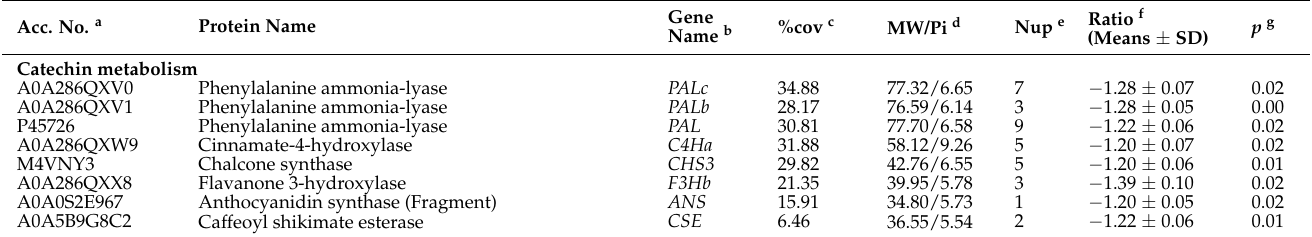
Figure 3. Concentration of catechins, gallic acid, caffeine and amino acids in leaves of pruned and unpruned tea plants. Data is presented as mean ± SD. * represents significant difference ( p < 0.05), ** represents extremely significant difference ( p < 0.01). C, catechin; CF, caffeine; EC, epicatechin; ECG, epicatechin gallate; EGC, epigallocatechin; EGCG, epigallocatechin gallate; GA, gallic acid; GC, gallocatechin; GCG, gallocatechin gallate; Ala, alanine; Arg, arginine; GABA, gamma-aminobutyric acid; Gln, glutamine; Glu, Glutamate; His, histidine; Ile, isoleucine; Leu, leucine; L-Thea, theanine; Thr, Threonine; Val, valine. Table 1. Differentially accumulated proteins related to biosynthesis of quality constitutes in tea leaves between long-term unpruned and pruned tea